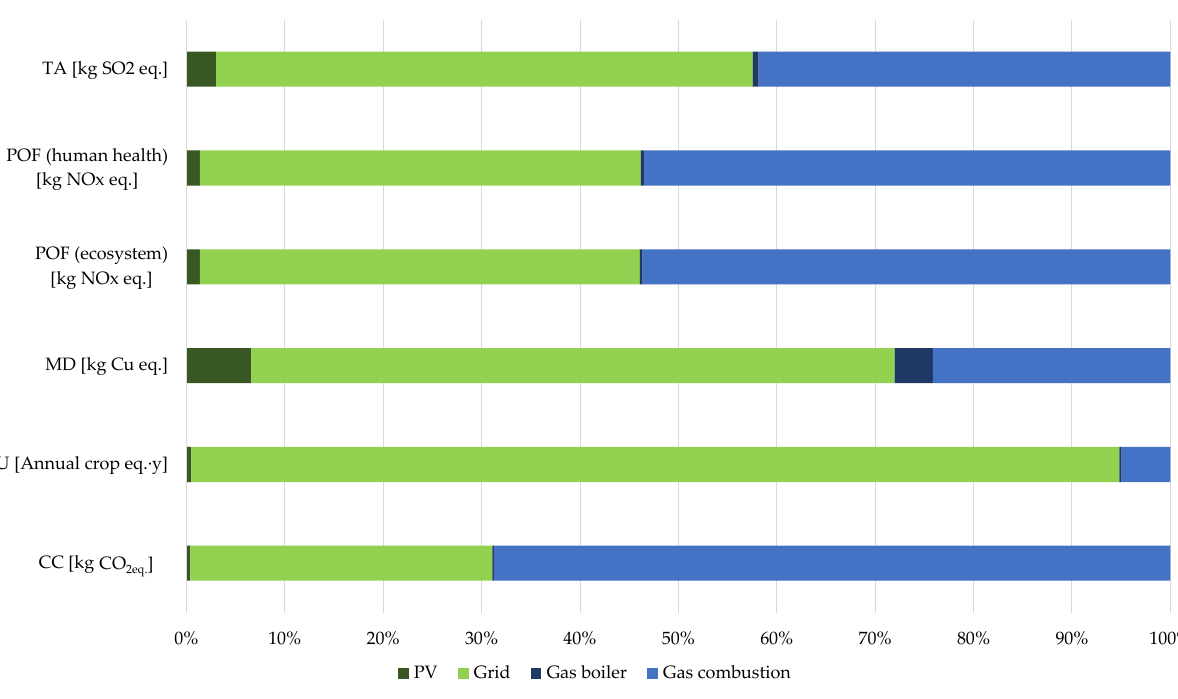
Figure 6. Results of cost-optimized, percentage distribution, and midpoint level. Abbreviations: CC = climate change, LU = land use, POF = photochemical ozone formation, TA = terrestrial acidifica- tion, MD = metal depletion.